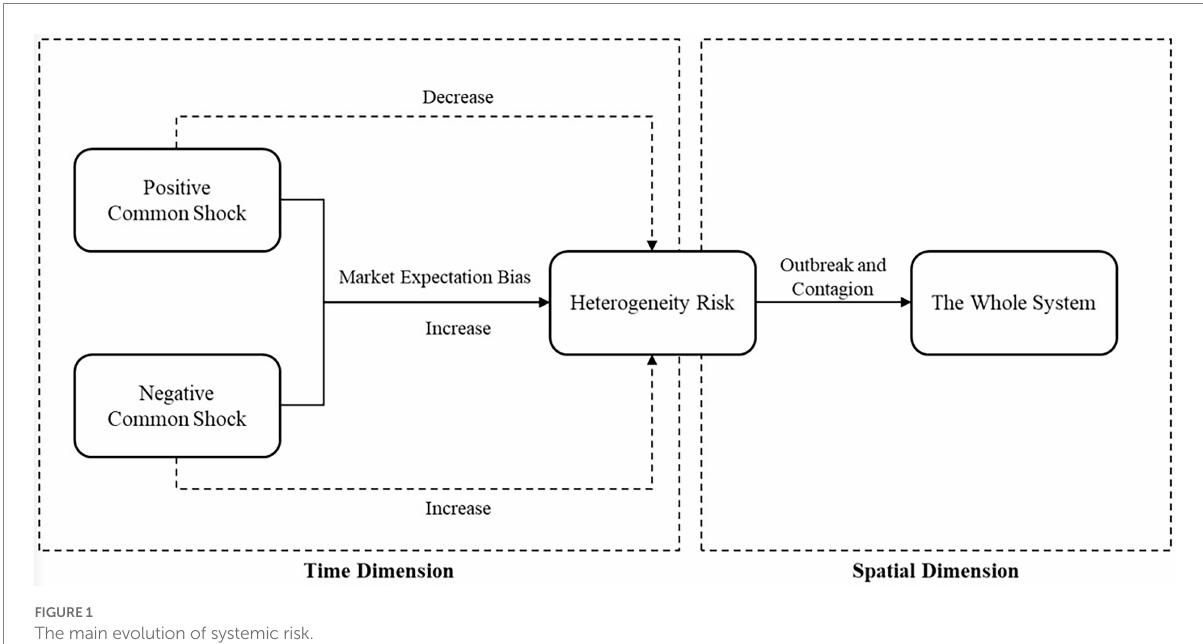
FIGURE 1 The main evolution of systemic